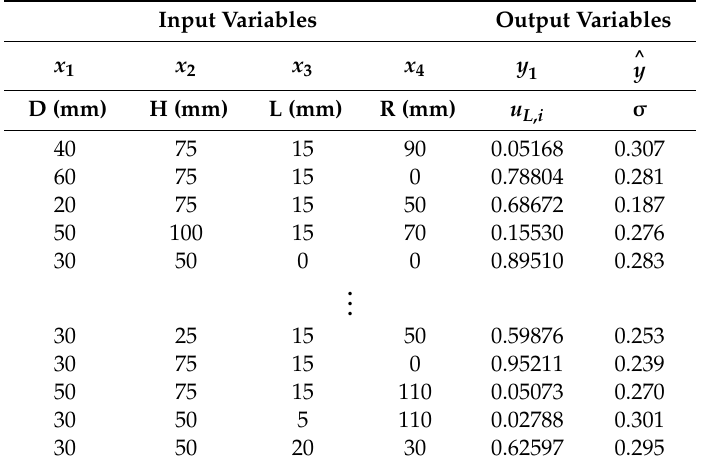
Table 1. Input and output variables of the support vector regression (SVR) model.